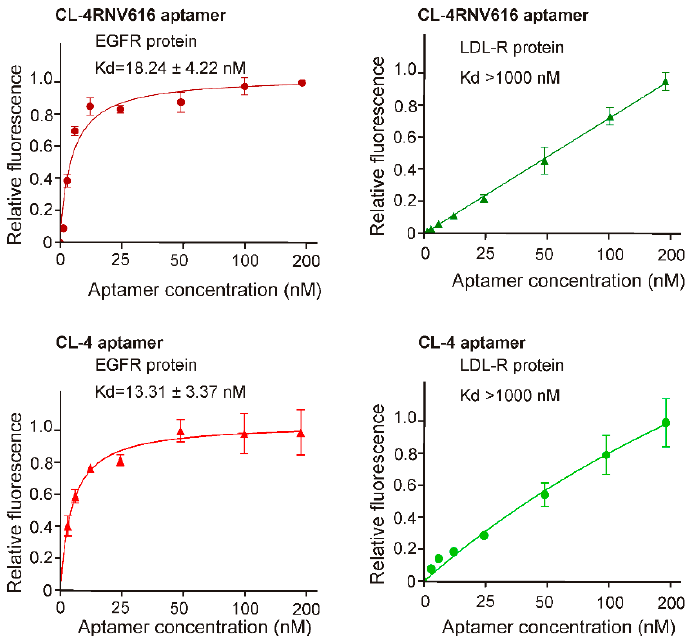
Figure 2. Determination of binding affinity of CL-4 and CL-4RNV616 aptamers to EGFR protein. Equilibrium dissociation constants ( K d ) was determined by incubating EGFR protein at varying concentrations of aptamer (0–200 nM) using LDL-R protein as a negative control. K d was derived using the GraphPad Prism program 8.0.